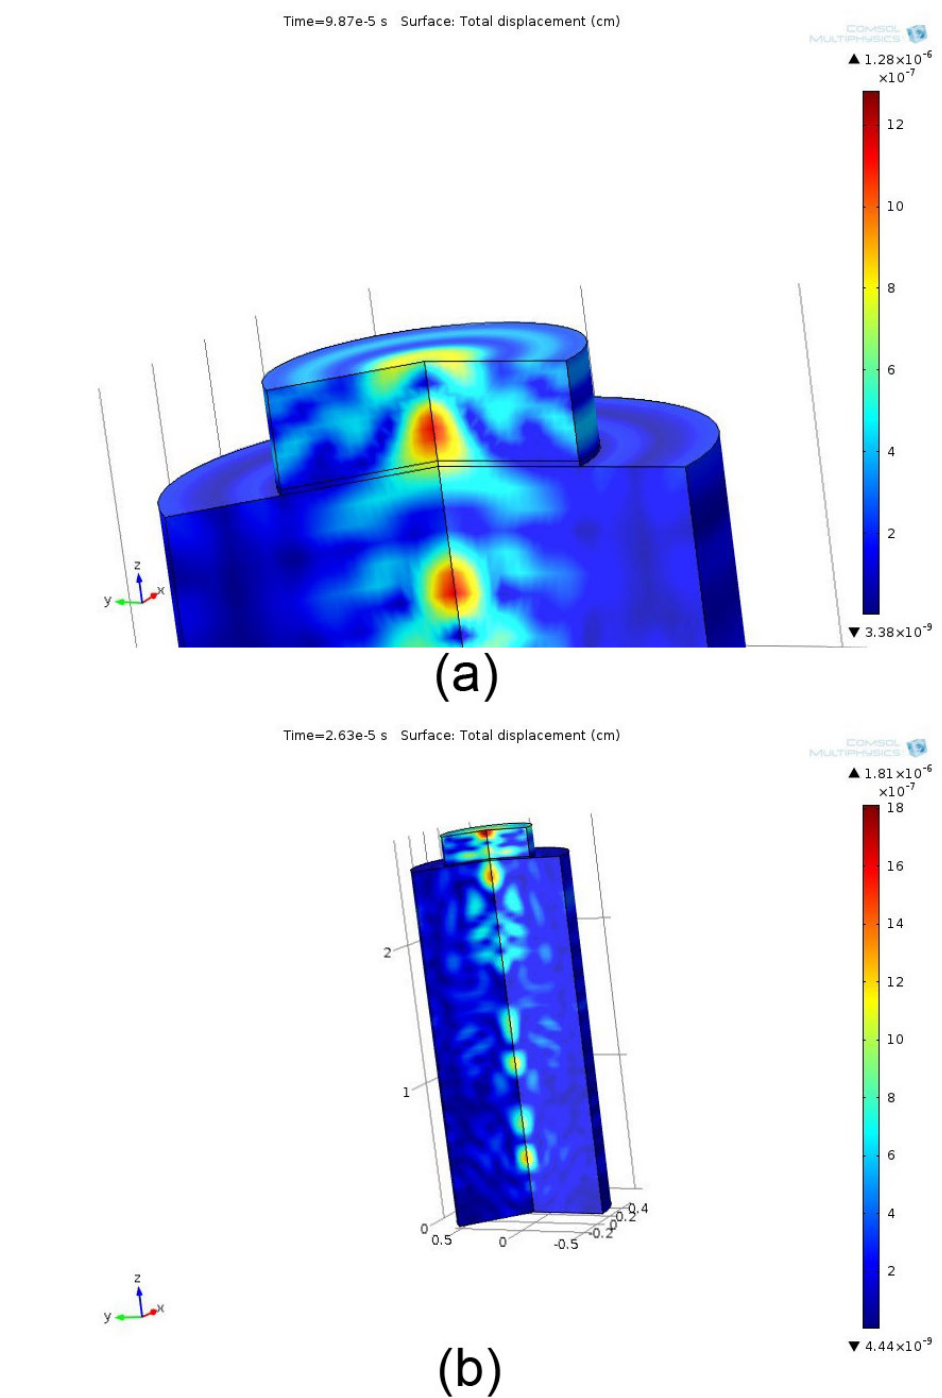
Figure 10. Example of the COMSOL displacement results for the Aremco glue used as the acoustic couplant excited at 1.1MHz at time = 26.3µs (4.10 a ) and time = 98.7µs. Notice how most of the energy is able to travel through the coupling layer, and there is dispersion of energy within the rod. Note that all amplitudes are in